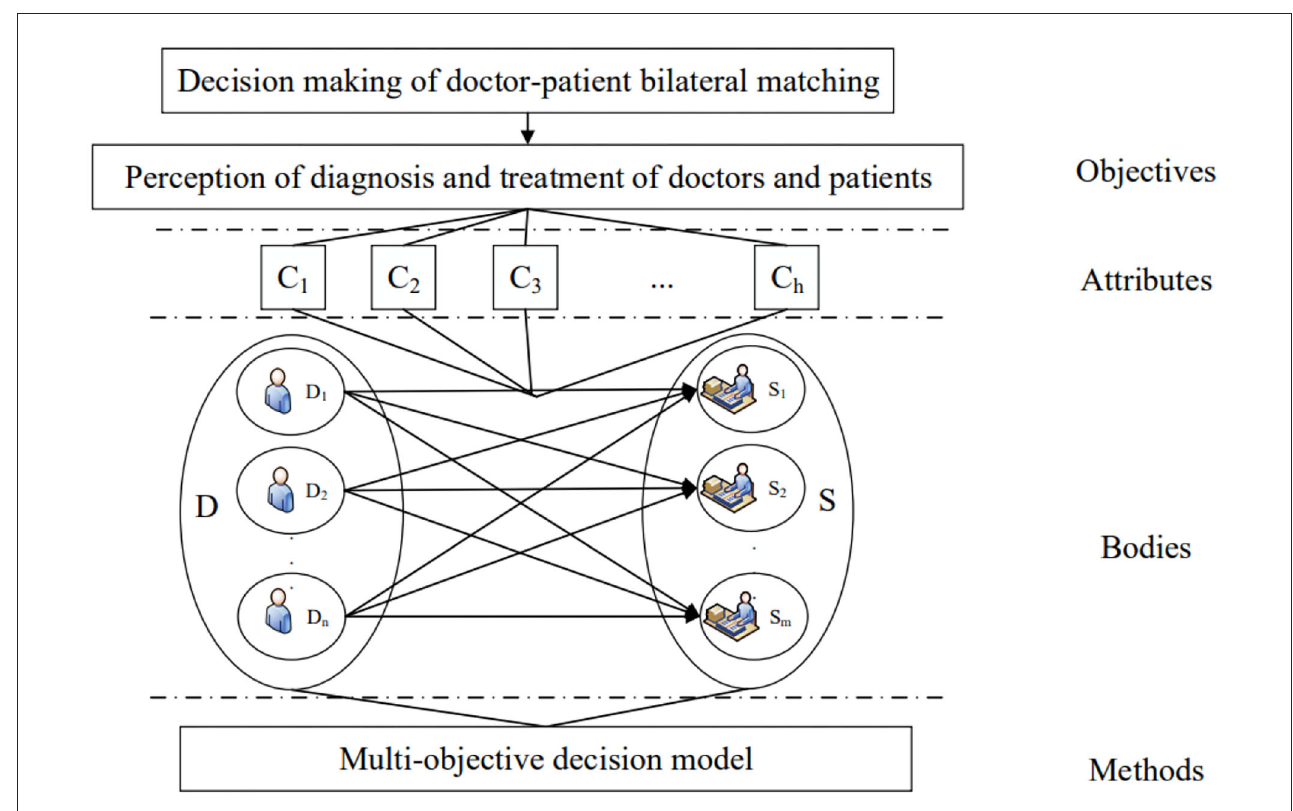
FIGURE1 The hierarchical structure of doctor-patient bilateral matching decision.